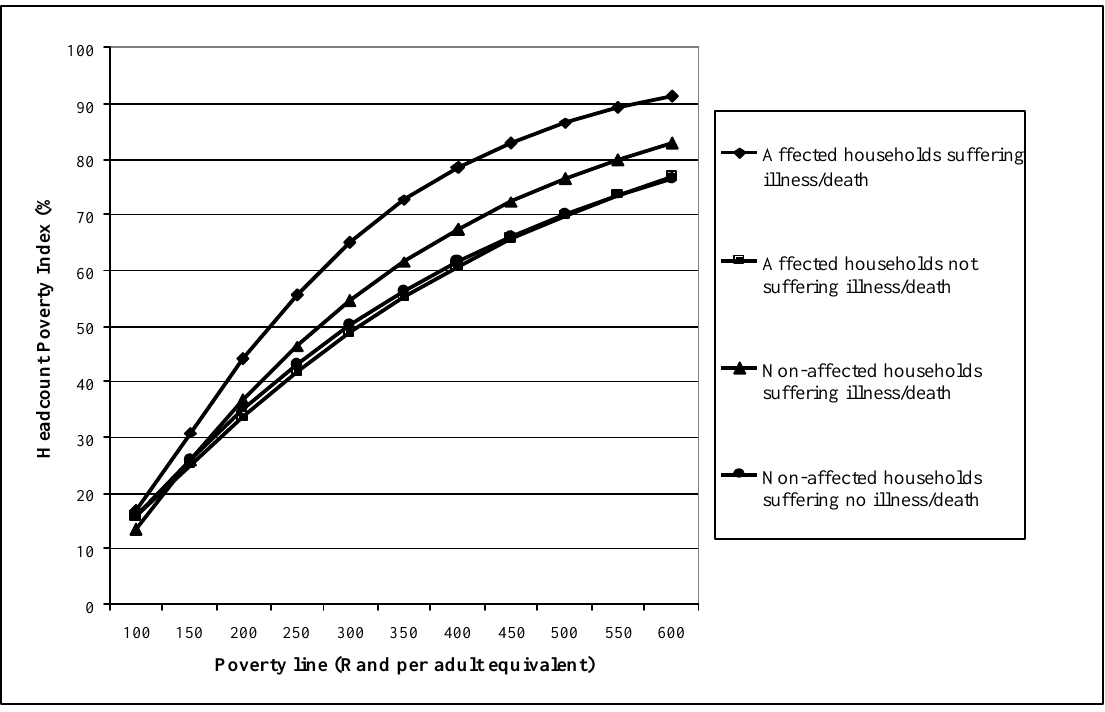
Incidence of poverty in affected and non-affected households by incidence of illness and/or death (wave